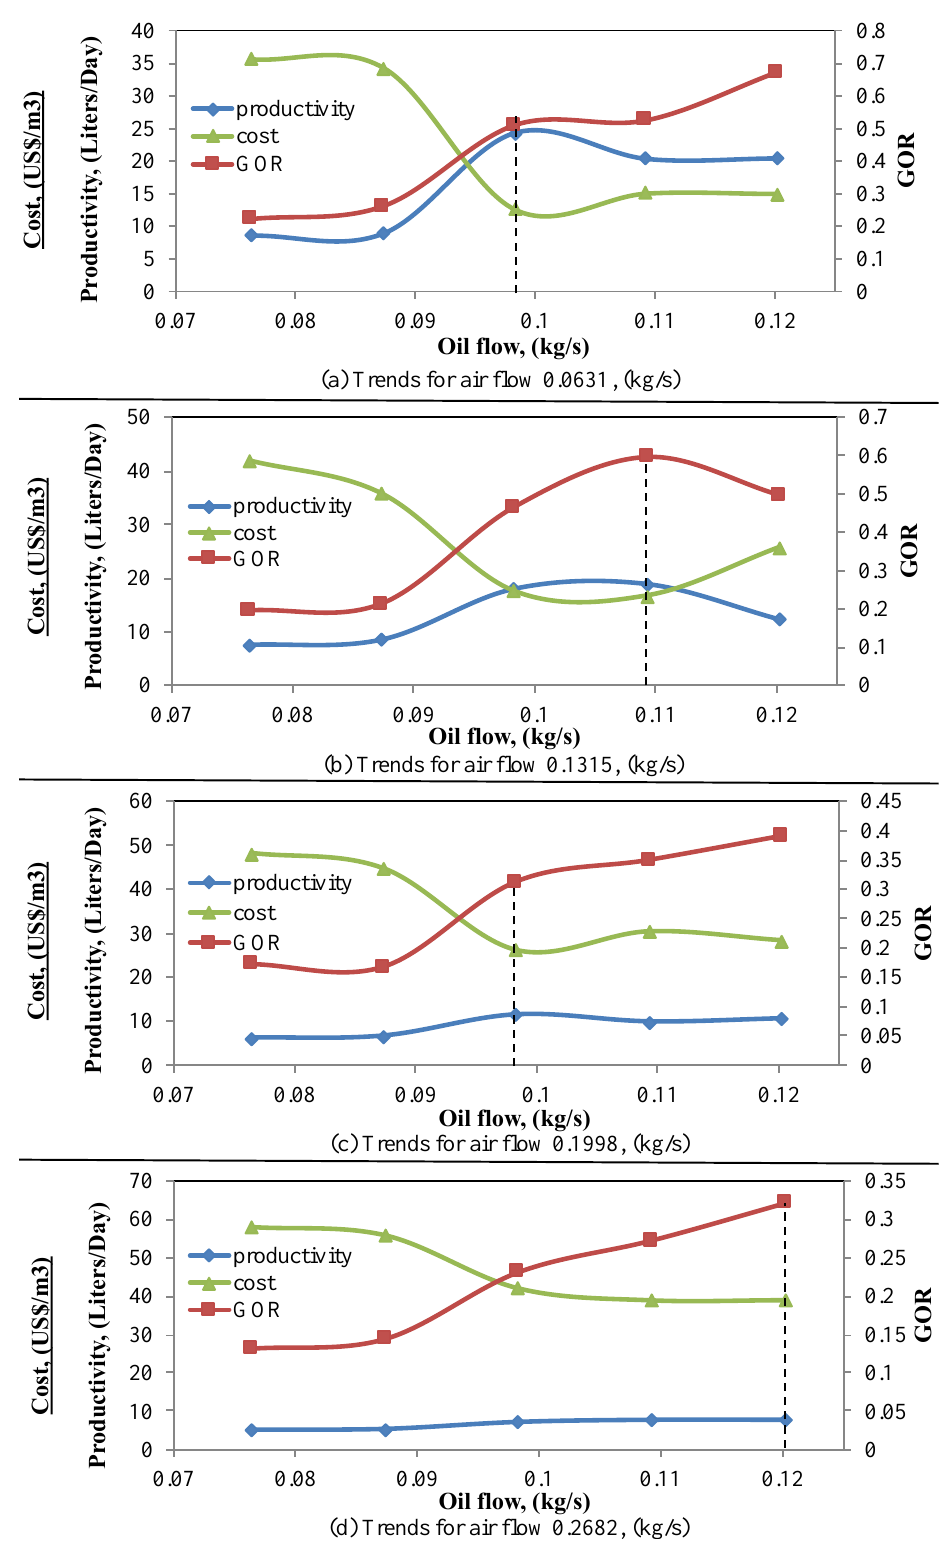
Figure 20. System optimization at different air and oil flow rates.